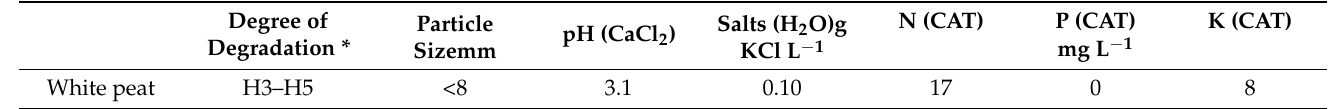
Table 3. Characterization of white peat. The degree of degradation according to the von Post scale and the particle size in millimeters taken from the manufacturer’s declaration. The pH is indicated in CaCl 2 [28]; water-soluble salts are expressed in grams of KCl per liter [29], and CAT-soluble N, P and K are expressed in milligrams per liter